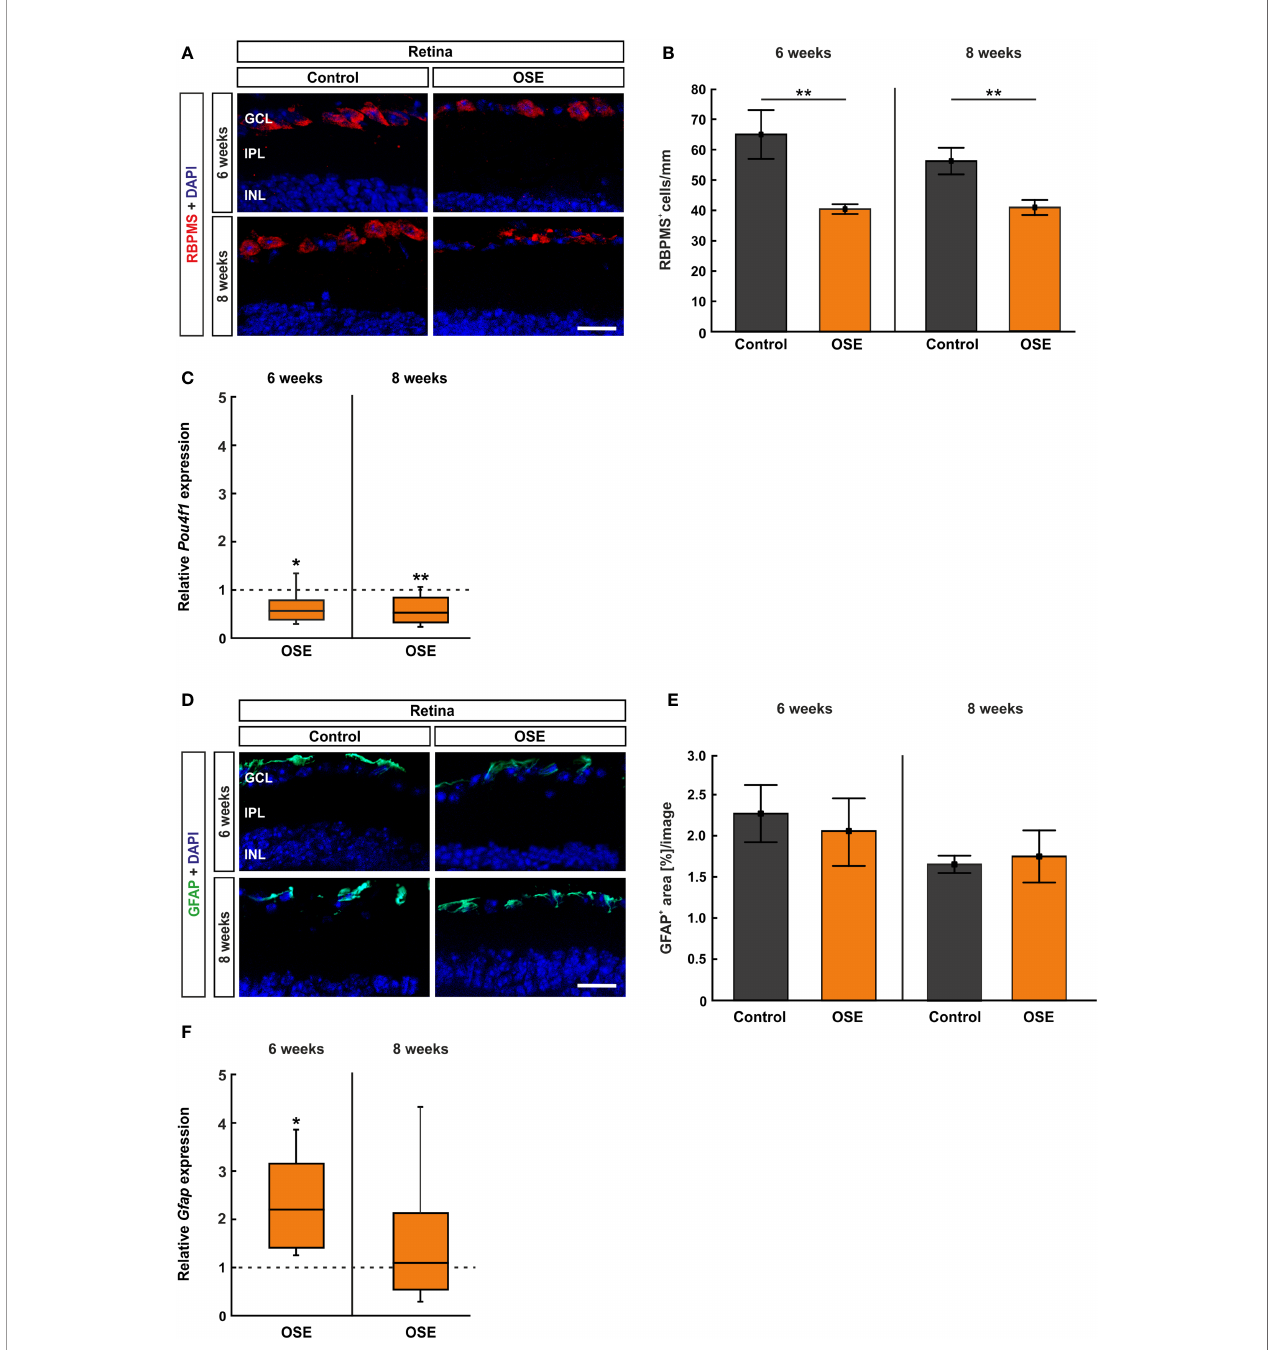
FIGURE 5 | Reduced number of retinal ganglion cells in OSE mice. (A) Retinal ganglion cells were stained with RBPMS (red) on retinal cross-sections. Cell nuclei were labeled with DAPI (blue). (B) The number of retinal ganglion cells was signi fi cantly reduced in the OSE group at six weeks. This reduction was also detectable in eight-week-old animals. (C) A signi fi cant downregulation of Pou4f1 mRNA was noted in OSE mice in comparison to the control group at six and eight weeks. (D) Immunohistological staining of retinal cross-sections with GFAP (green) and DAPI (blue) was performed to label macroglia. (E) The GFAP + area evaluation revealed no signi fi cant differences between both groups at both ages. (F) The expression of Gfap mRNA was signi fi cantly increased in OSE mice at six weeks, but no changes were detectable at eight weeks. Data are mean ± SEM for immunohistochemistry, relative values for RT-qPCR are median ± quartile ± maximum/ minimum. The dotted lines in (C, F) represent the relative expression level of the control group. GCL, ganglion cell layer; IPL, inner plexiform layer; INL, inner nuclear layer. *p < 0.05, **p < 0.01. Scale bars: 20 m